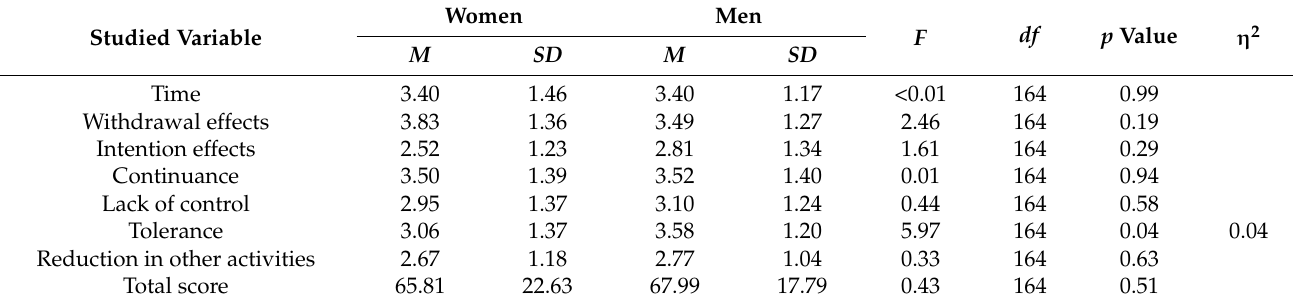
Table 6. Comparison of results by sex of